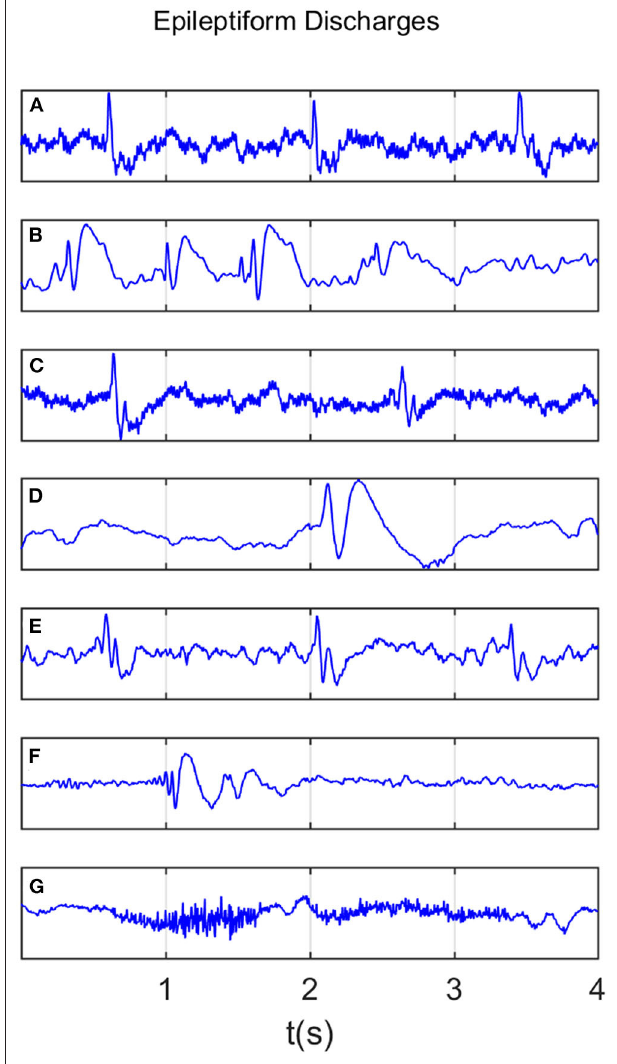
FIGURE 1 | Typical waveforms of the 7 major epileptiform EEG, where (A–G) , denotes spike wave, spike and slow wave complex, sharp wave, sharp and slow wave complex, polyspike complex, polyspike and slow wave complex, spike rhythm discharges,